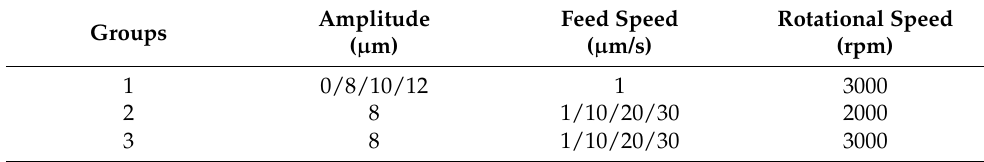
Table 3. Machining parameters of the experiment.